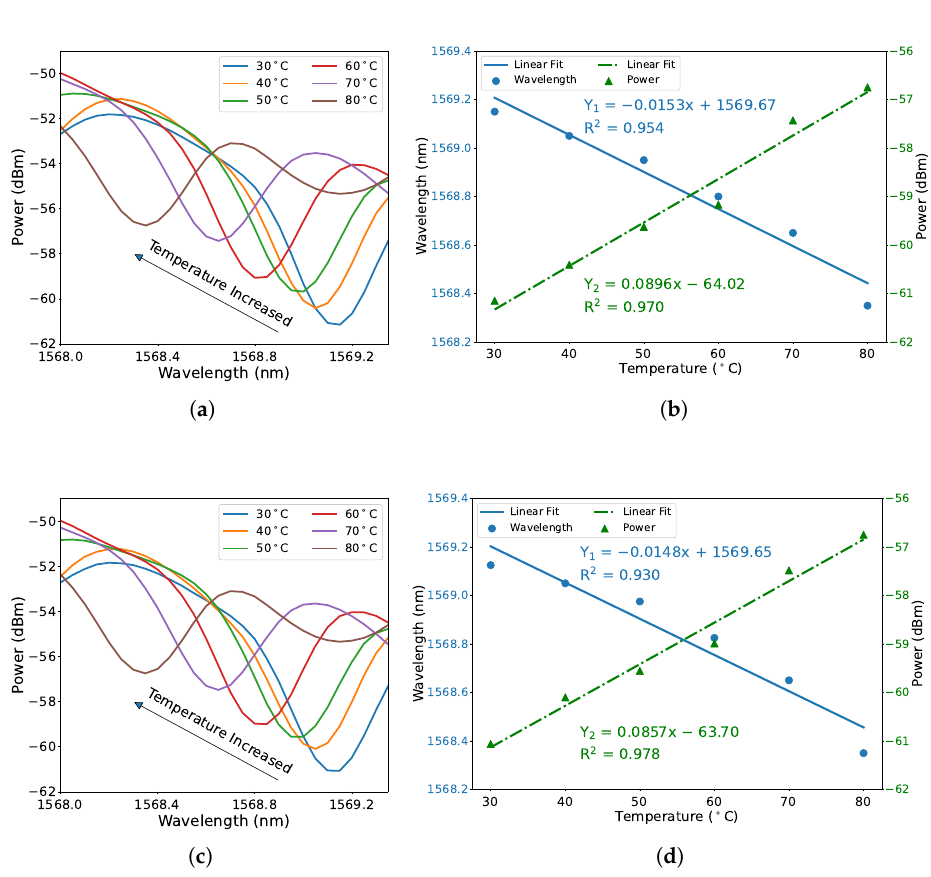
Figure 3. Measured dependence of spectral dip shifts on temperature in the range of 30 ◦ C to 80 ◦ C in steps of 10 ◦ C, ( a ) first round and ( c ) second round. Dip shift as a function of temperature, ( b ) first round and ( d ) second round. The blue solid line represents dip wavelength shift against temperature, and the green dash-dot line represents dip power against